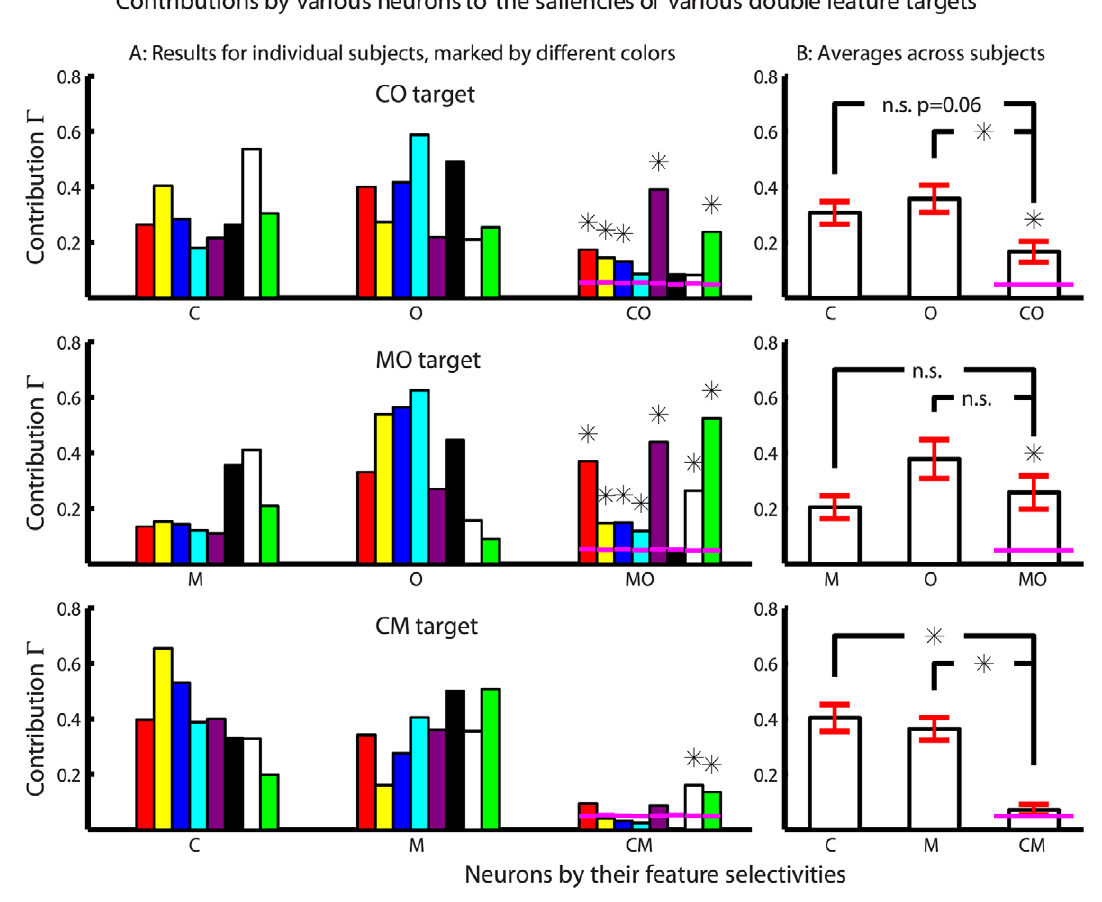
Figure 7. Contributions by various feature-tuned neurons to the three types of double feature targets. Results are shown for individual subjects in A and averaged across subjects in B. The two subjects marked by white and green colored bars are Koene and Zhaoping, experimenters for the behavioral data and the only non-naive subjects. The plots are in the same format as that in Fig. 6B. In B, C chance is averaged across subjects, and a subject-averaged contribution by the conjunctive cells is marked as significant if it is significantly different ( p v 0 : 05 ) from this C chance by a t-test. The error bars mark the standard errors of the means. An ‘*’ above a bar for the double feature tuned cell (in A or B) indicates that the contribution by this cell (to the saliency of the double feature target) is significantly above the chance level. In B, an ‘*’ or ‘n.s.’ linking the contribution of a conjunctive cell and that of a single feature tuned cell marks, respectively, a significant or insignificant difference between them (by a matched sample t-test). Qualitatively the same results are obtained in B when data from non-naive subjects, Koene and Zhaoping, are